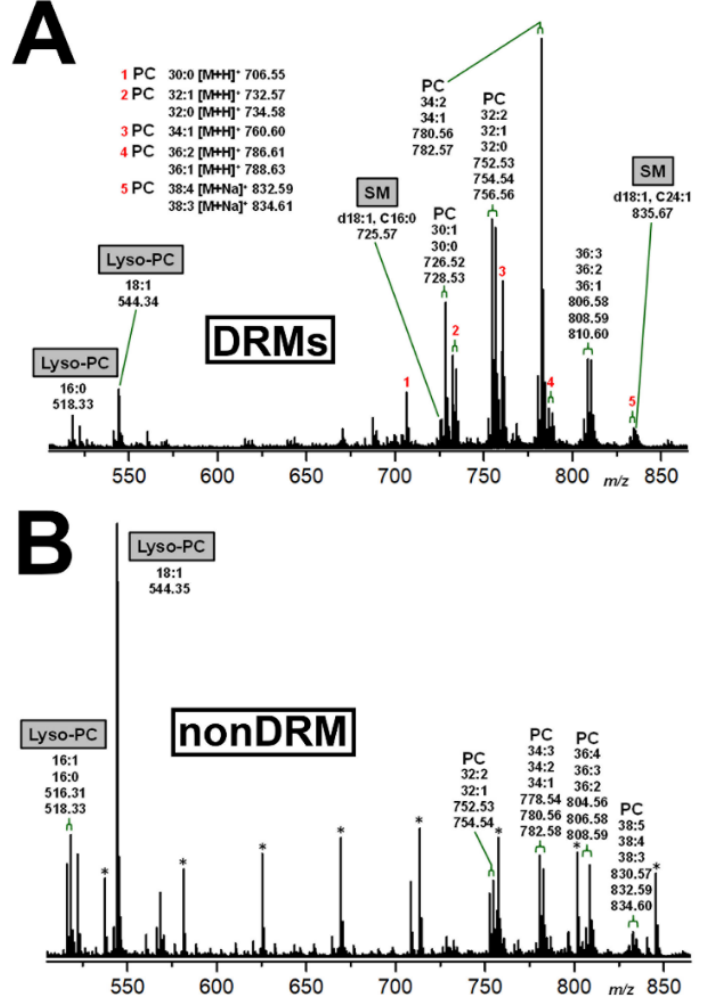
Figure 9. Phospholipid MS 1 spectra of DRM ( A ) and nonDRM fractions ( B ) derived from low-serum cultivated pHCoEpiCs. MS spectra of combined lipid extracts from DRM F2 and F3 and nonDRM F7 fractions of replicate 1 obtained in the positive ion mode are exemplarily shown. Unless otherwise stated, the detected sodiated species ([M+Na] + ) are assigned. The SM species occurring only in DRMs are considered as markers of the liquid-ordered membrane phase and highlighted as grey boxes. The lyso-PCs in the nonDRM fraction can be considered as markers for the liquid-disordered membrane phase due to their exorbitant content in the nonDRM fraction F7 and are framed in grey boxes as well. The asterisks mark polyethylene glycols (PEGs) appearing as serial contaminations in the lipid